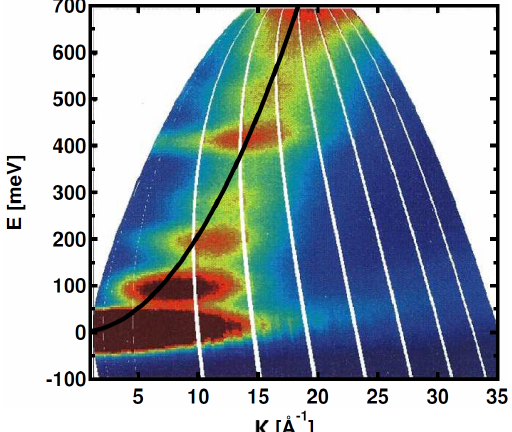
Figure 3. Measured S ( K , E ) intensity map of ice Ih at 20 K and 1 bar, recorded on MARI [22]. E 0 = 750 meV. The shown black line (parabola) is the conventional recoil trajectory of a free H. The strong intensity ribbon at E ≈ 0 is mainly due to the aluminum cell containing the water (ice). The intensity peak maximum at E ≈ 420 meV and K ≈ 14 Å − 1 represents the vibrational stretching OH-vibrations. (Reproduced from Ref. [21] with